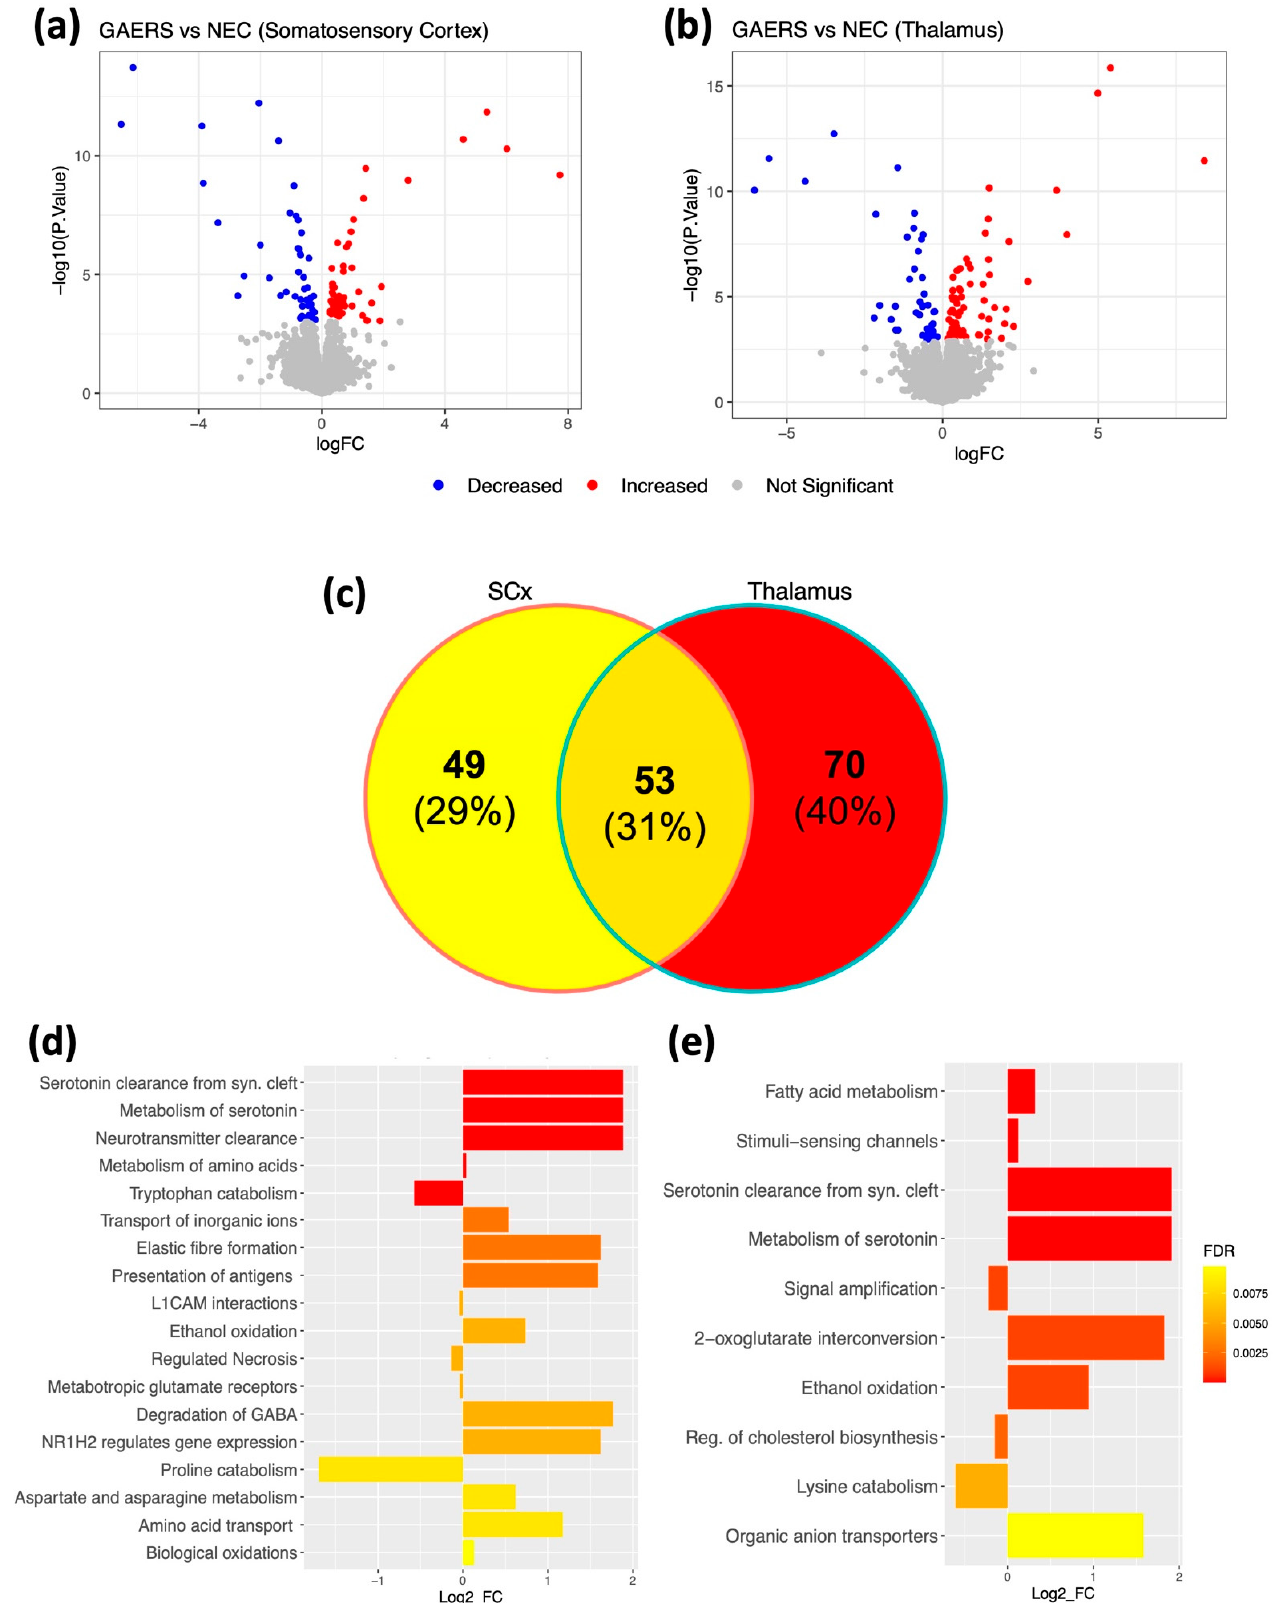
Figure 2. Proteomic profiling of the somatosensory cortex (SCx) and thalamus of GAERS compared to NEC. Top: Volcano plots showing the changes in the abundance of all quantified proteins (log 2 FC,